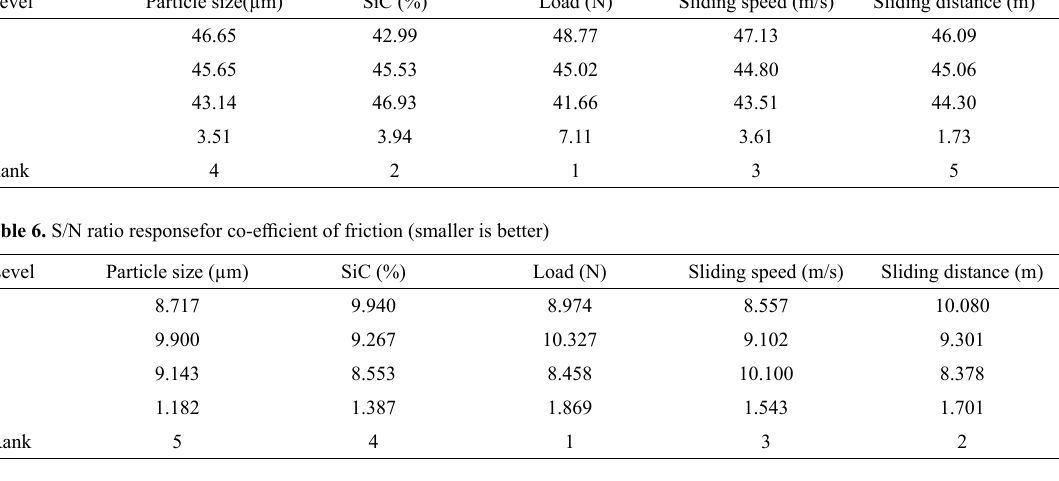
Table 5. S/N ratio response for wear rate (smaller is better) Level